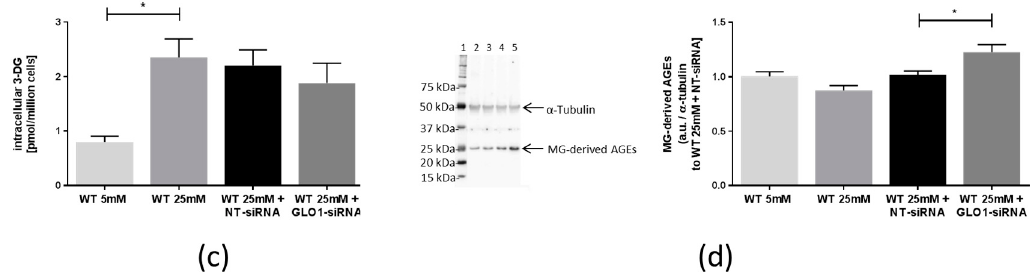
Figure 2. Analysis of formation of methylglyoxal (MG), glyoxal, 3-deoxyglucosone (3-DG), and methylglyoxal-derived advanced glycation end products (AGEs). ( a ) MG content of L6 myoblasts transfected with non-target siRNA and GLO1 specific siRNA following 48 h siRNA transfection. Data are mean ± SEM ( N = 3, n = 3). Significance: ** p < 0.01, WT 25 mM + GLO-siRNA vs. WT 25 mM + NT-siRNA; ( b ) glyoxal content of L6 myoblasts transfected with non-target siRNA and GLO1 specific siRNA following 48 h siRNA transfection. Data are mean ± SEM ( N = 3, n = 3). Significance: * p < 0.05, WT 25 mM + GLO-siRNA vs. WT 25 mM + NT-siRNA; ( c ) 3-DG content of L6 myoblasts transfected with non-target siRNA and GLO1 specific siRNA following 48 h siRNA transfection. Data are mean ± SEM ( N = 3, n = 3). Significance: * p < 0.05, WT 25 mM vs. WT 5 mM; ( d ) Western Blot analysis for MG-derived AGE content of L6 Myoblasts transfected with non-target siRNA and GLO1 specific siRNA following 48 h siRNA transfection. Lane 1: Precision Plus Protein Standard; lane 2: WT 5 mM; lane 3: WT 25 mM, lane 4: WT 25 mM + NT-siRNA; lane 5: WT 25 mM + GLO1-siRNA; Data are mean ± SEM ( N = 3, n = 3). Significance: * p < 0.05, WT 25 mM + GLO-siRNA vs. WT 25 mM + NT-siRNA.